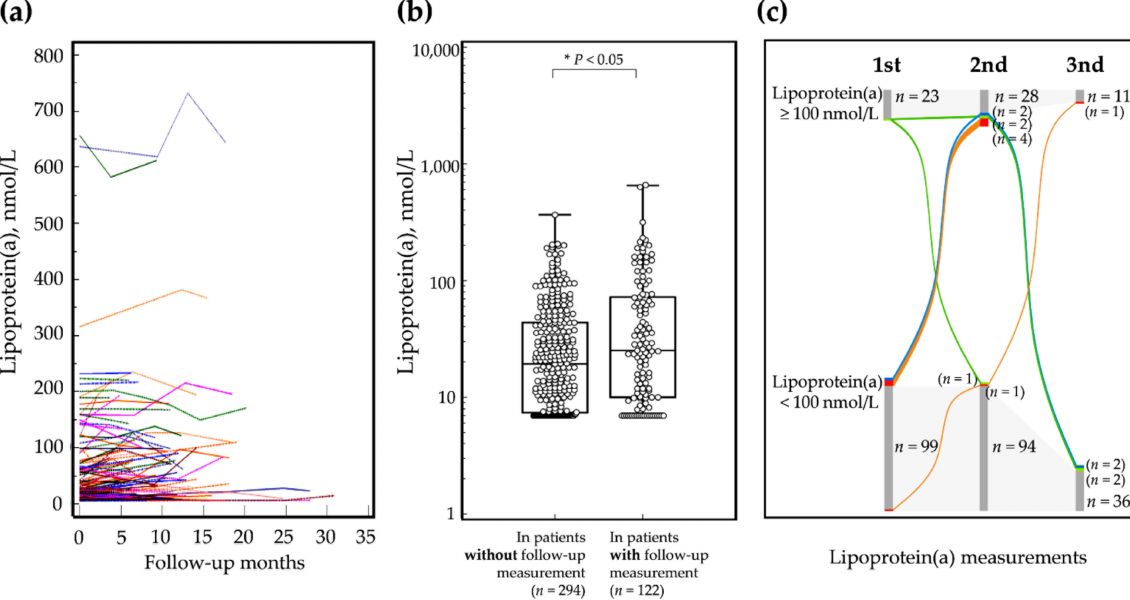
Figure 2. Intra-individual changes in serum lipoprotein(a): ( a ) Individual data in 122 subjects during follow-up; ( b ) Comparison of initial serum lipoprotein(a) in patients who experienced (or not) follow-up serum lipoprotein(a) levels >100 nmol/L in 416 children; ( c ) Sankey diagram showing the percentages of children that maintained stable lipoprotein(a) and that showed changes (who experienced serum lipoprotein(a) >100 nmol/L during follow-up) among 416 children. Gray flows indicate cases of stable lipoprotein(a); colored flows indicate cases that experienced changes in serum lipoprotein(a) levels during follow-up; green flows indicate cases that experienced initial serum lipoprotein(a) ≥ 100 nmol/L that decreased to <100 nmol/L ( n = 2); red flows indicate cases that experienced initial serum lipoprotein(a) <100 nmol/L that increased to ≥ 100 nmol/L ( n = 5); blue flows indicate cases that experienced initial serum lipoprotein(a) <100 nmol/L, that increased to ≥ 100 nmol/L and then decreased to < 100 nmol/L (fluctuation, n = 2). Number of subjects is available on the right side of the bar of each